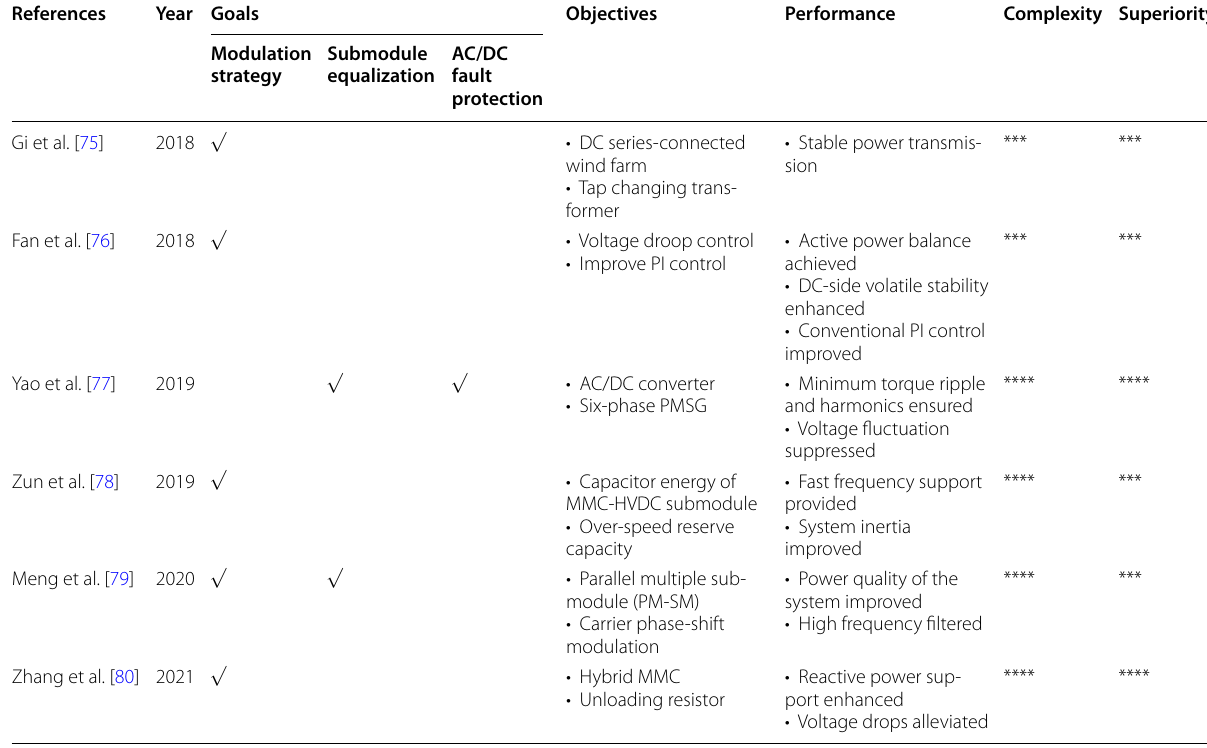
Table 3 MMC-HVDC of OWFs